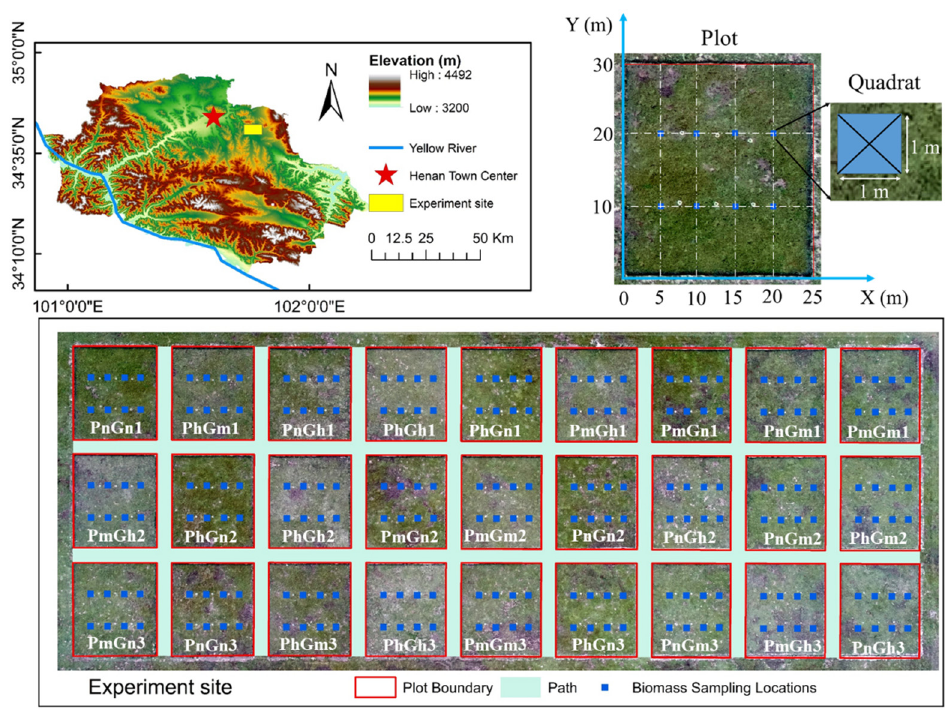
Figure 1. Location of the study site and the experiment settings (1, 2, 3 represent three replications of the same treatment).